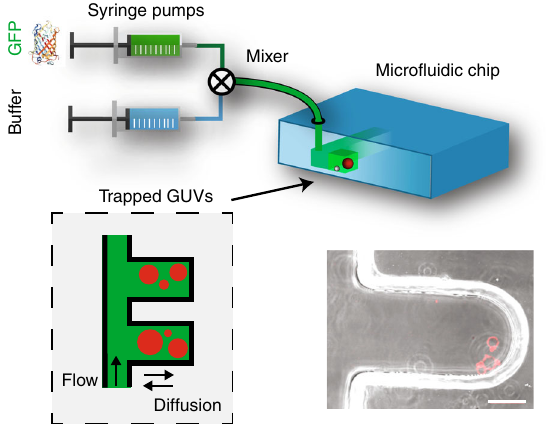
Fig. 6 Design of micro fl uidic chips for the exposure of GUVs to different solution conditions. Cartoon and image of GUVs (red) located in micro fl uidic dead-end channels that acted as vesicle traps (bottom) and solution conditions outside the GUVs were set by computer-controlled syringe pumps (top). The solutes reached the GUVs by diffusion into the traps (Supplementary Movie 4). In this way, the GUVs were screened from mechanical perturbations arising from hydrodynamic fl ows in the main channel. Scale bar for the lower right image: 50 μ